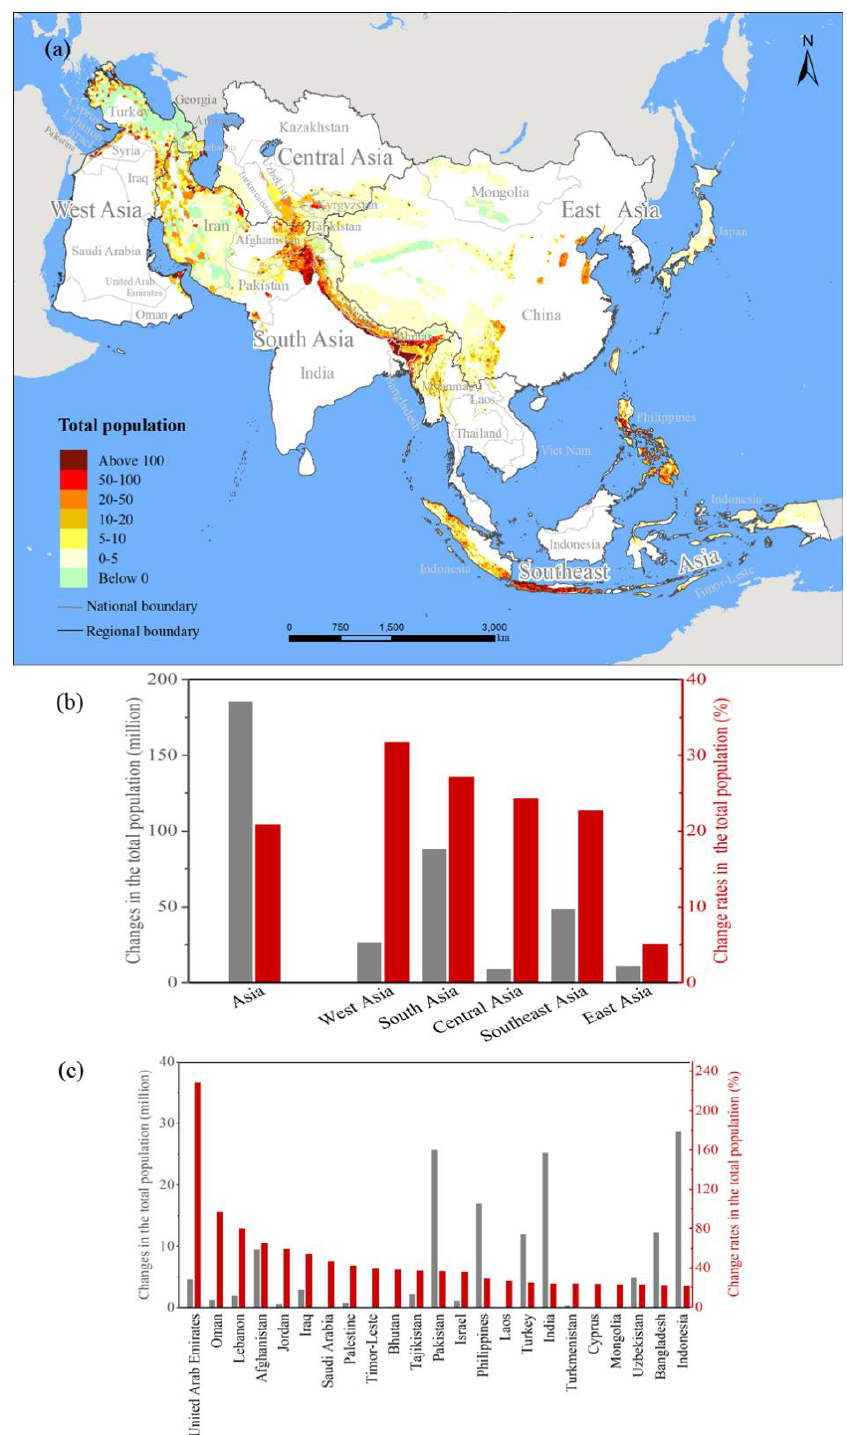
Figure 3. Changes in the total populations living among different MSHA from 2000 to 2015. ( a ) The total population density, unit: people/km 2 ; ( b ) The change rates in the total population in the MSHA of Asia; ( c ) The change rates in the total populations living in the MSHA of the selected countries. (The countries were selected when the total population in an MSHA increased from 2000 to 2015) .